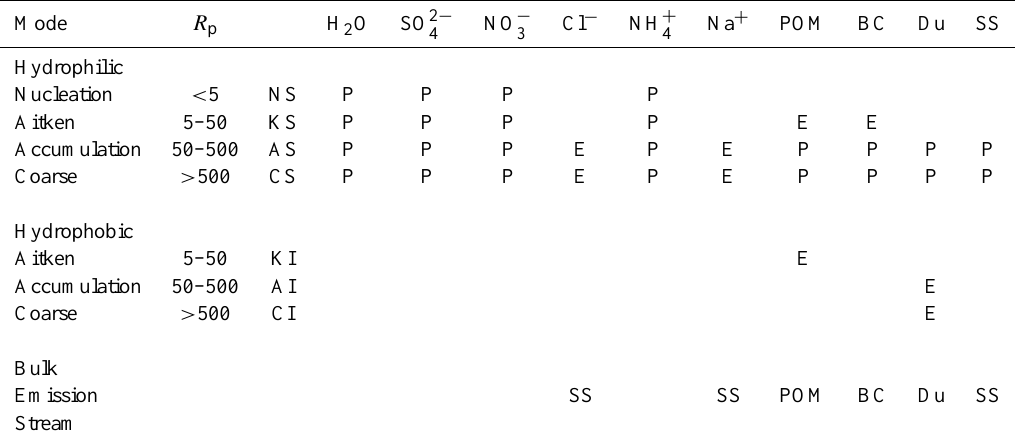
Table 2. Example setup of the GMXe submodel, as used in this work (other combinations/setups are possible). Aerosol species are distributed between the 4 hydrophilic and 3 hydrophobic aerosol modes. E=Emitted into the mode, P=Permitted in the mode. BC=black carbon, POM=particulate organic matter, SS=sea spray, Du=dust. R p =radius